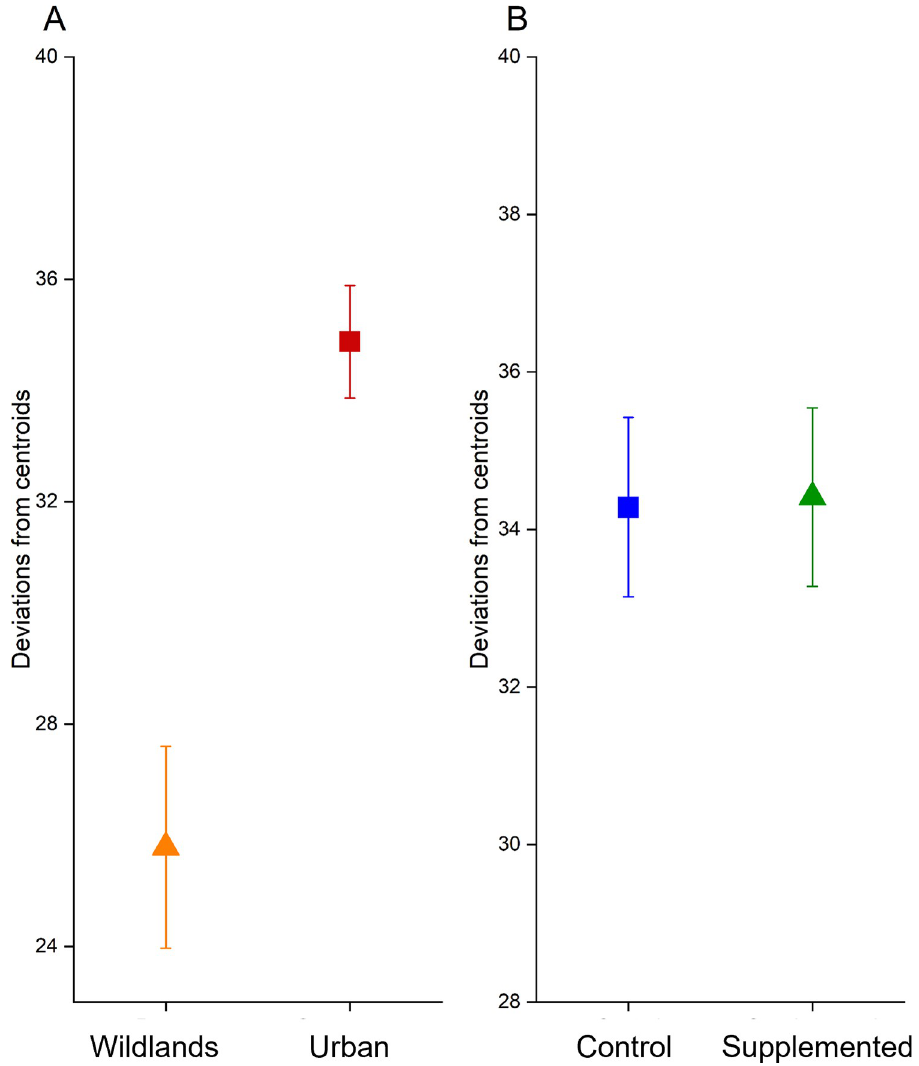
Fig 2. β -diversity (deviations from centroids) across sites with differing levels of (A) urbanization (High = ‘Urban’ and Low = ‘Wildlands’) and (B) nectar supplementation (High = Supplemented and Low = Control). Deviations from centroids were significantly different between site types but not different for nectar supplements vs . control plants. (Permdisp P ST = 0.0005, P TRT = 0.9509). Factors with different letters were significantly different according to a post- hoc pairwise Permdisp (P < 0.05) Error bars represent ± 1 standard error of the